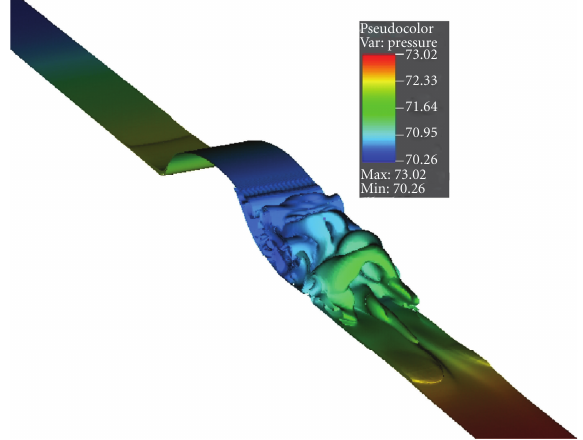
Figure 14: Vorticity isosurfaces (shaded by pressure) for DES